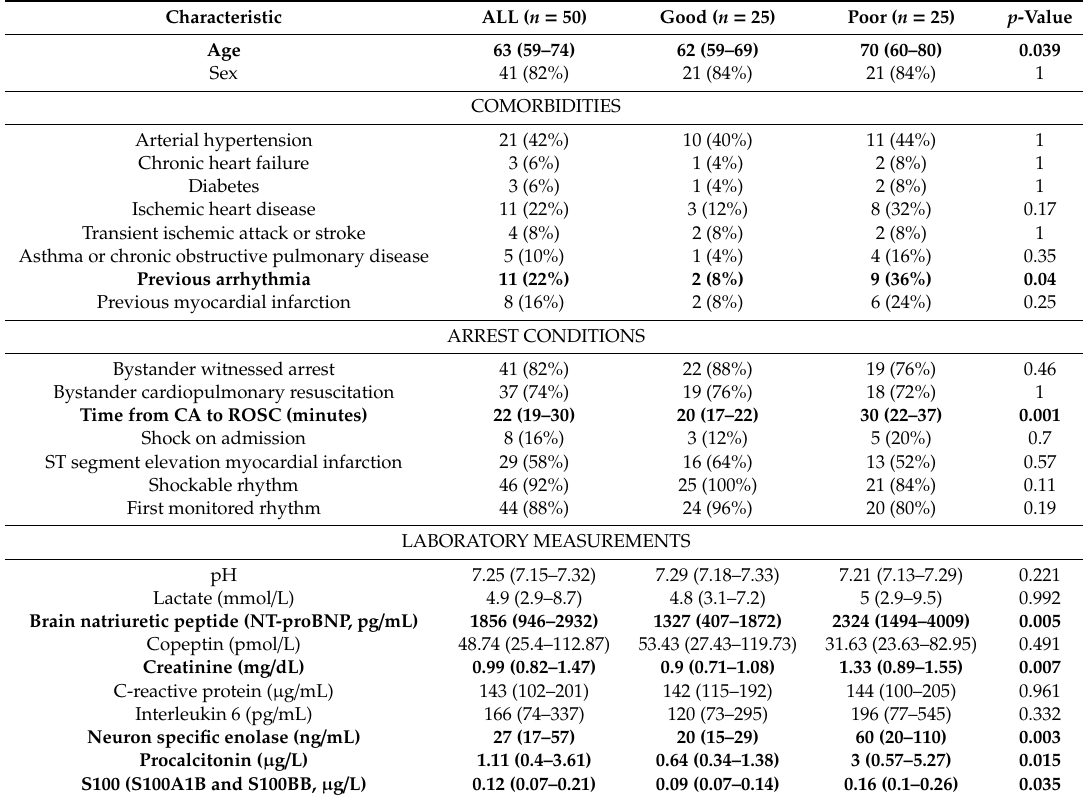
Table 1. Demographic and clinical characteristics of the study